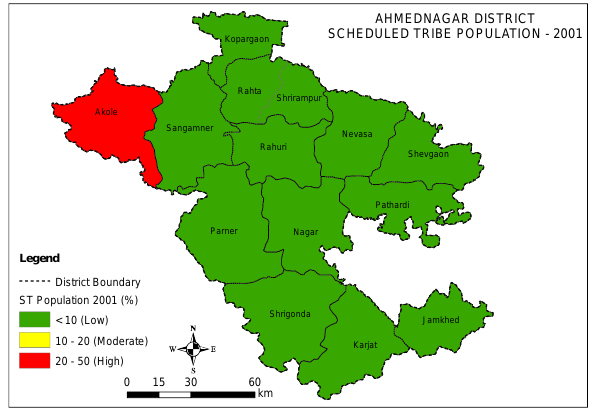
Figure 2. Scheduled Tribe population in Ahmednagar District,